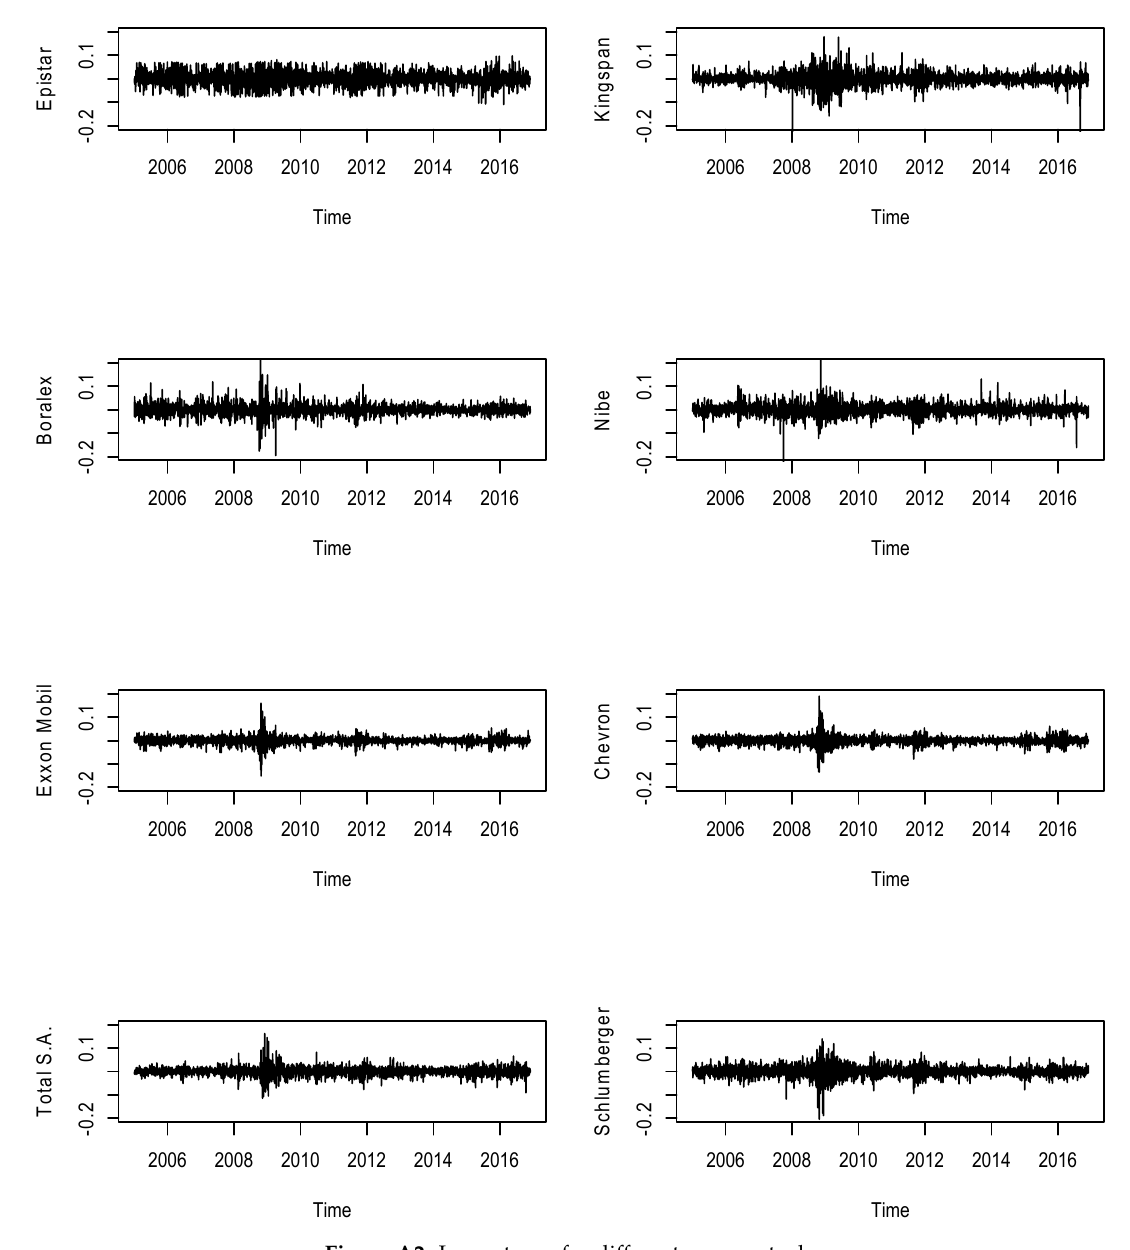
Figure A2. Log-returns for different energy stocks.